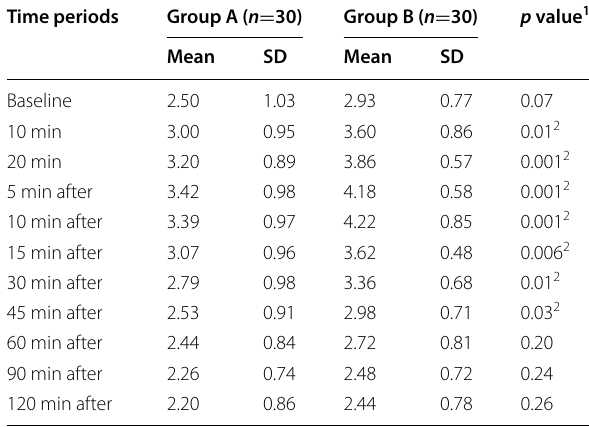
Table 3 Comparison of stroke volume (SV) between the groups across the time periods